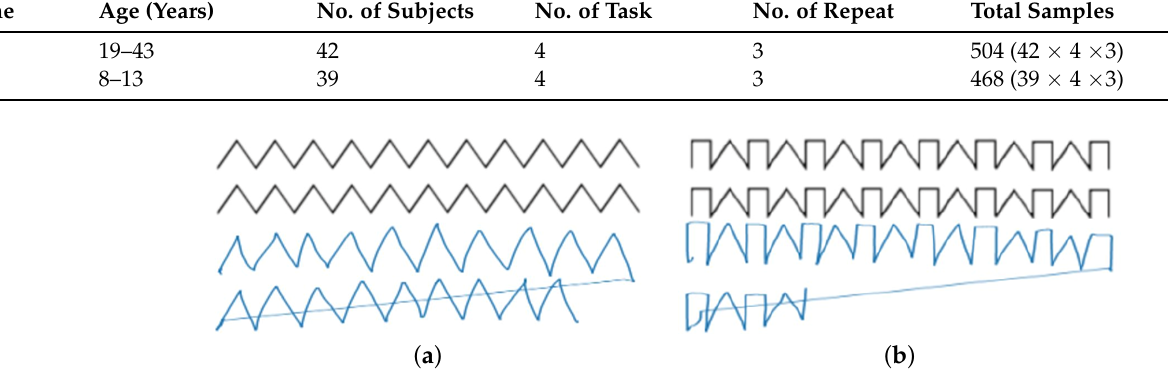
Figure 3. Handwritten pattern dataset for ( a ) zigzag line sample and painted; ( b ) PL line sample and